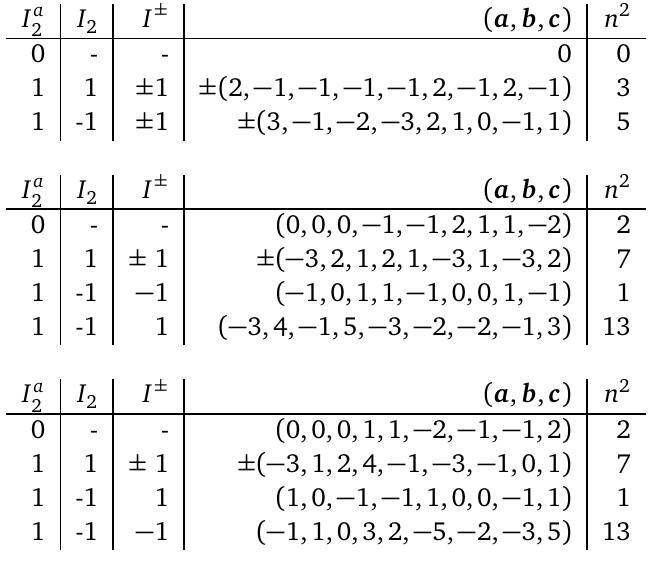
Table 2: Examples of configurations of winding numbers ( a , b , c ) with the smallest norm n 2 , in the Kempe sectors labeled by ( I a to bottom). One can check that a + b + c = 0, a